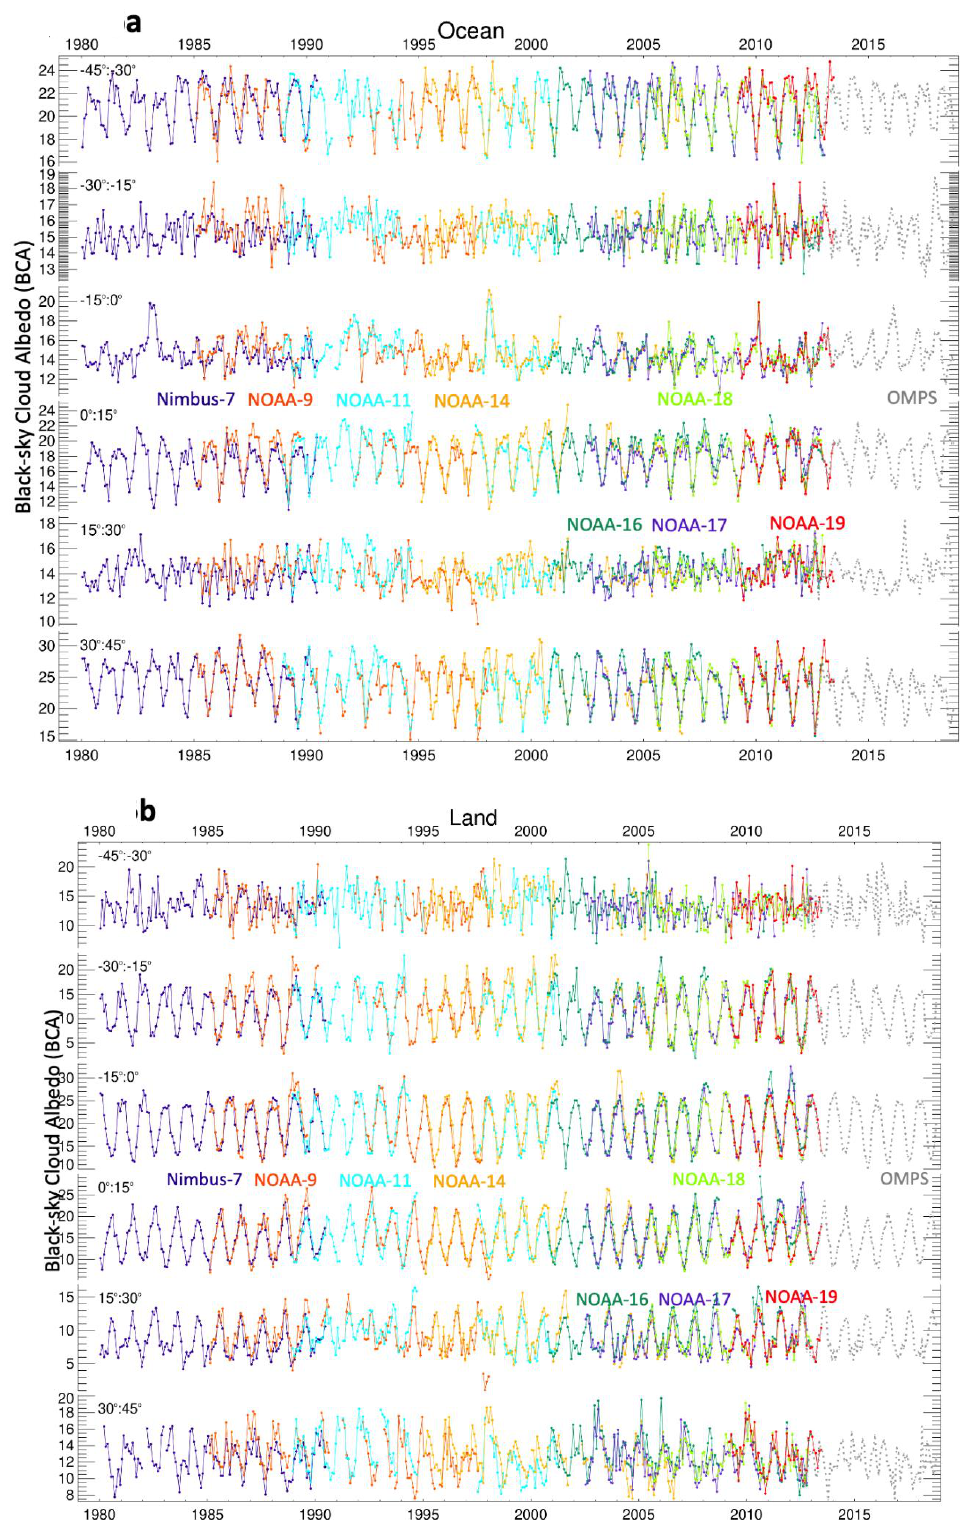
Figure 6. Monthly mean values of BCA (%) from the SBUV and the OMPS instrument for six 15°-wide latitude bands and from 45°S to 45°N over ( a ) ocean and ( b ) land.